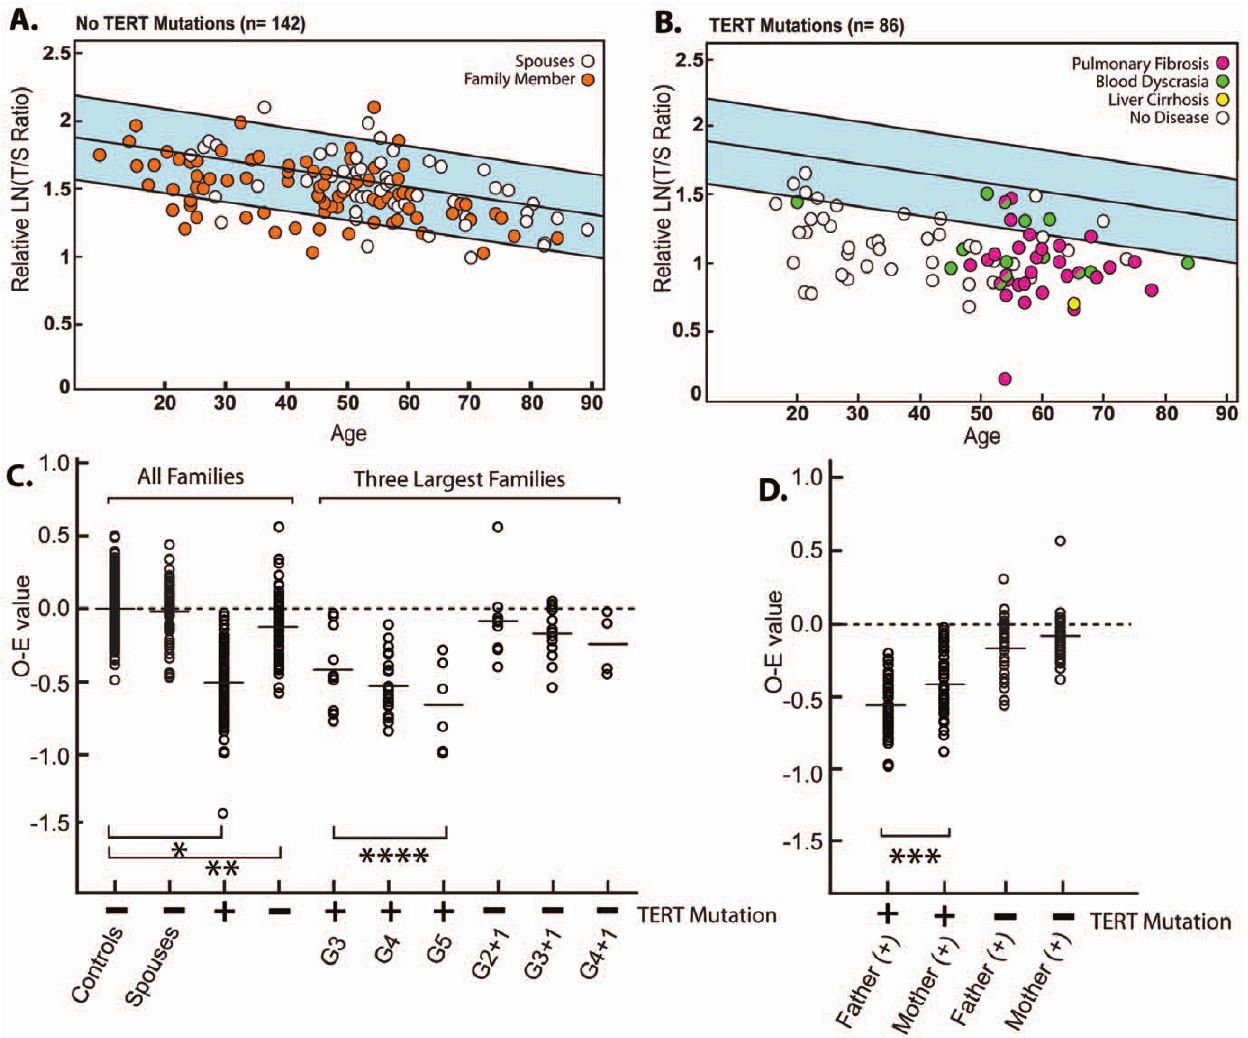
Figure 2. Telomere lengths of family members from TERT kindreds. Mean telomere lengths as measured by a quantitative PCR assay for ( A ) normal subjects and ( B ) subjects with TERT mutations are plotted against age. ( A ) The telomere lengths of spouses (open symbols) and family members without TERT mutations (orange filled symbols) are shown relative to the 50 th percentile (center line) and the 10 th to 90 th percentiles for 195 unrelated healthy individuals from 19–89 years of age (blue shaded region). ( B ) TERT mutation carriers without any clinical disease (open circles), with pulmonary fibrosis (red symbols), blood dyscrasias (green symbols) and liver cirrhosis (yellow symbols) are plotted against the same reference range. ( C ) Mean observed minus expected age-adjusted telomere length for the indicated groups. The minimum number of successive generations the TERT mutation has segregated in the kindred is indicated; G3 indicates subjects in the third successive generation with TERT mutations, i.e., the children with TERT mutations whose parents and grandparents also had a TERT mutation. G2 + 1 indicates subjects who do not have a telomerase mutation and are the offspring of individuals that represent the second successive generation with a TERT mutation. Bars show the mean value. ( D ) Mean observed minus expected age-adjusted telomere lengths for offspring of TERT mutation carriers with ( + ) and without ( 2 ) the mutation. Mean telomere lengths are shorter for offspring of fathers who carry a TERT mutation. P-values of 2.4 6 10 2 38 (*),1.01 6 10 2 5 (**), 0.01 (***) and linear trend test P-value of 0.04